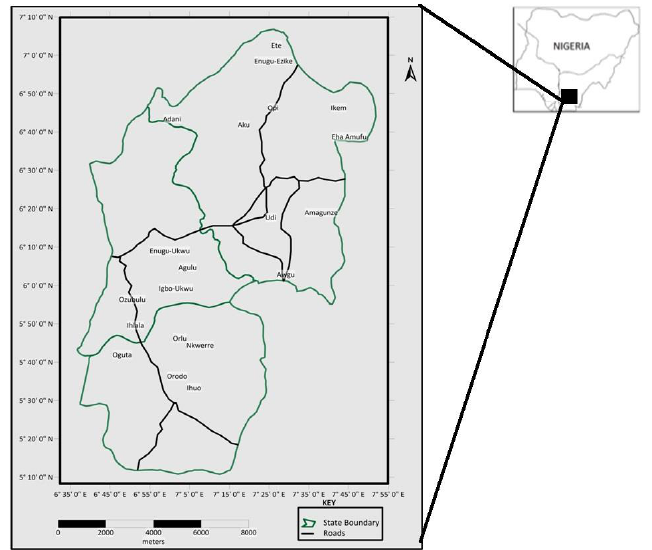
Figure 1: Landslide Points at two different locations Anambra and Imo State Southeastern Nigeria.